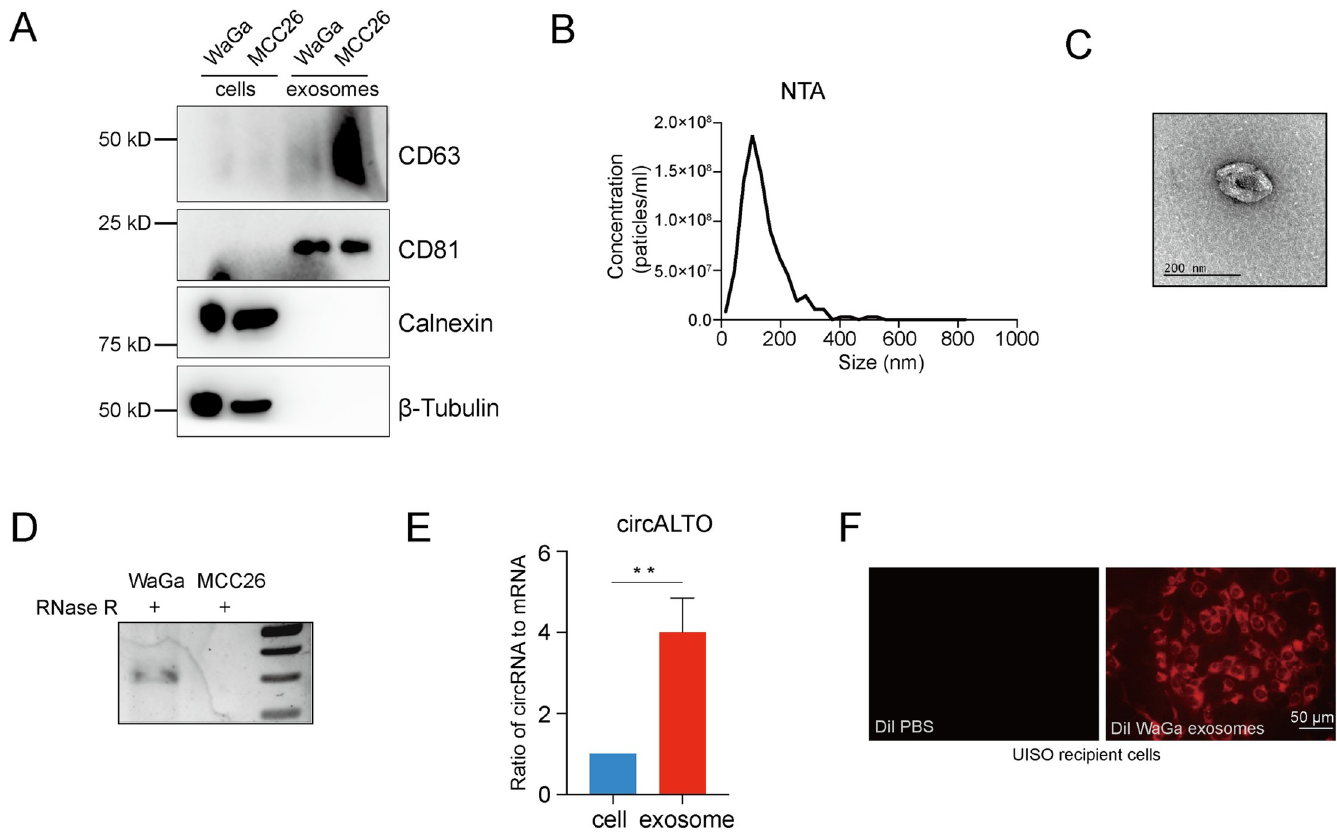
Fig 5. Characterization of exosomes from WaGa cells. (A) Western blot analysis of exosomal marker proteins in extracellular vesicles isolated from VP-MCC cell line WaGa and VN-MCC cell lines MCC26. CD63 and CD81 are exosomal marker proteins. The absence of calnexin and β -tubulin exclude contamination from the cytoplasm and cellular organelles. (B) Nanoparticle tracking analysis of extracellular vesicles isolated from WaGa cells are consistent with exosomes. (C) Representative TEM images of exosomes isolated from WaGa cells show the expected size and cup-shaped morphology described for exosomes. (D) RT-PCR analysis of RNase R treated total RNA prepared from exosomes of WaGa and MCC26 cells reveals the presence of circALTO in the exosomes. (E) qRT-PCR analysis the ratio of circRNA to mRNA between WaGa cells and cell-derived exosomes. Both circALTO and linear ALTO were first normalized to ACTB , then the ratio of circALTO:linear ALTO was set as 1. Error bars represent the SD (n = 3 biological replicates). Two-tailed t-test was performed, �� < 0.01. (F) Fluorescence of UISO cells incubated with DiI labeled exosomes from WaGa or Dil labeled PBS control by fluorescent microscopy. Scale bar = 50 μ